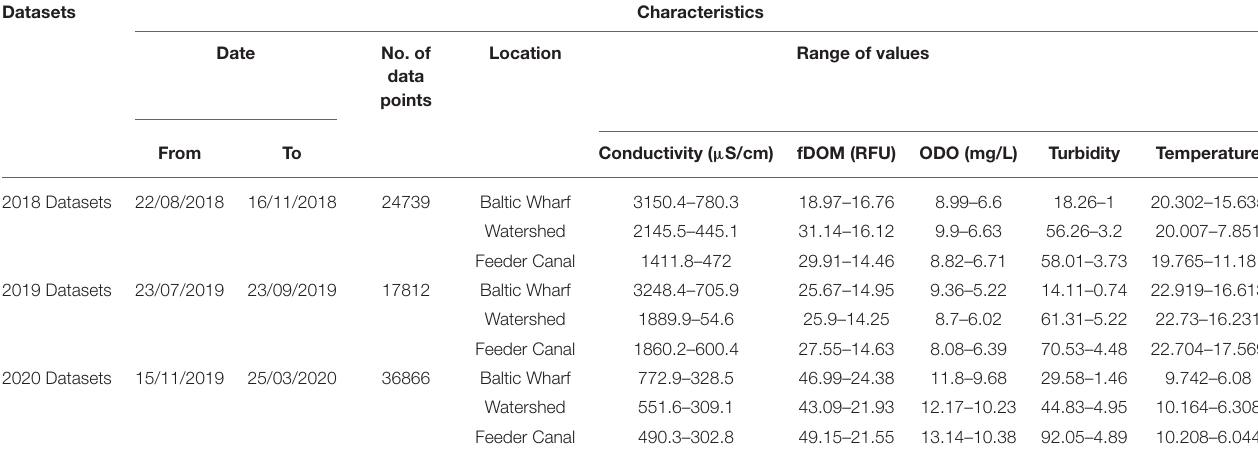
TABLE 3 | Dataset